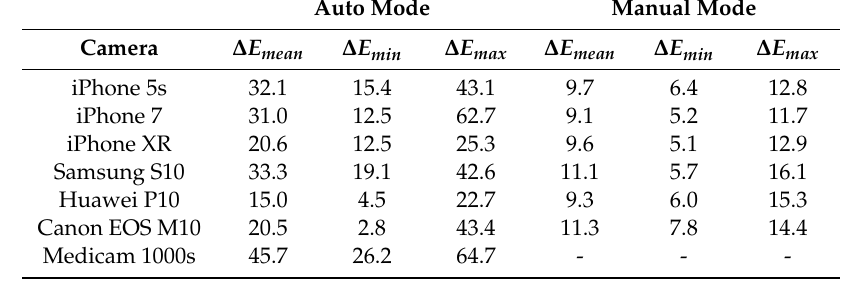
Table5. Colourreproductionaccuracyisgivenforautoandmanualmodecamerasettingasmean ∆ E mean colour distance, minimal ∆ E min and maximal ∆ E max value regarding the six skin tone reference colours.